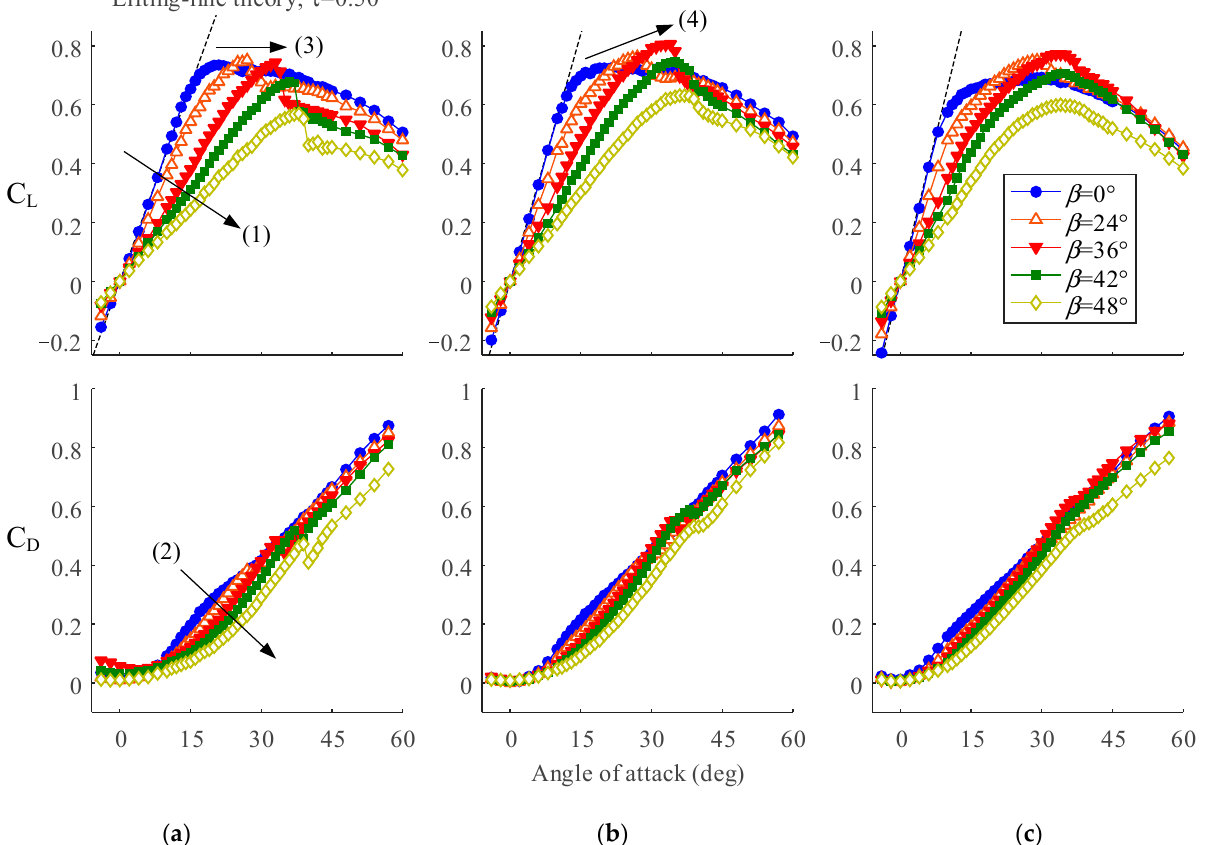
Figure 4. C L – α and C D – α curves with respect to β . ( a ) AR = 2.03; ( b ) AR = 3.13; ( c ) AR = 4.50.